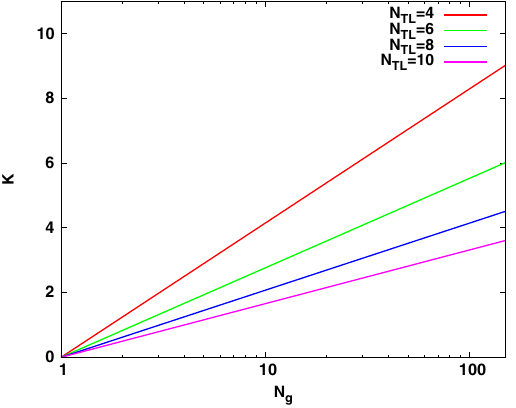
FIG. 2. Comparison of the computational load for the FFT method with the computational load for the method based on Taylor expansion. The ratio of the computational loads K ¼ 5 log 2 N =N as a function of number of grid points N g TL is shown for a different number of Taylor terms N